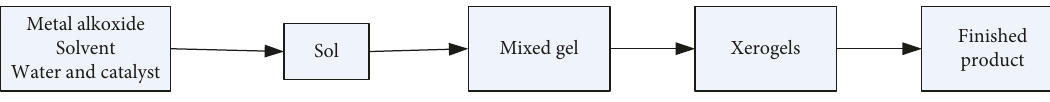
Figure 6: Flowchart of the sol-gel method. Table 5: Required reagents and their